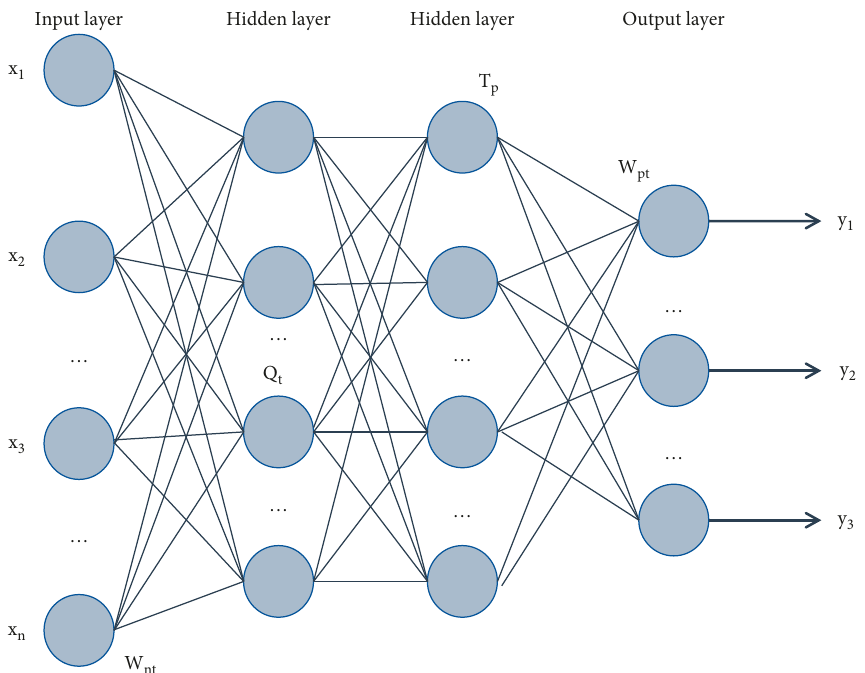
Figure 6: Structure diagram of multilayer feedforward